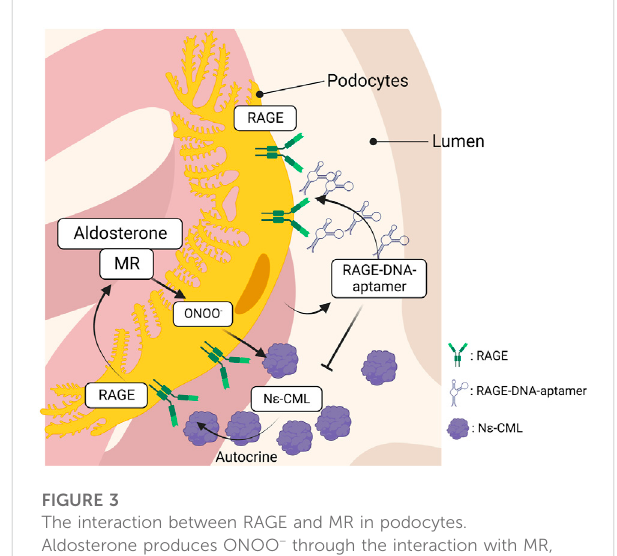
FIGURE 3 The interaction between RAGE and MR in